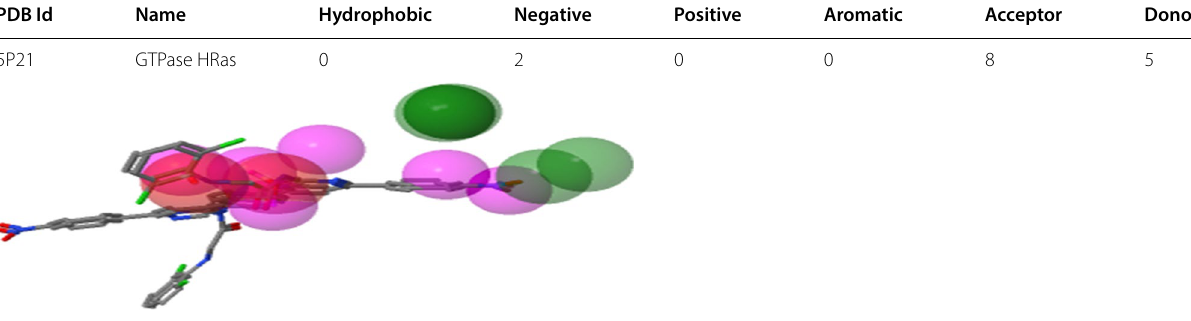
Table 3 Pharmacophoric features of GTPase HRas protein aligned over most potent compound 18 [green: donor, magenta: acceptor, red: